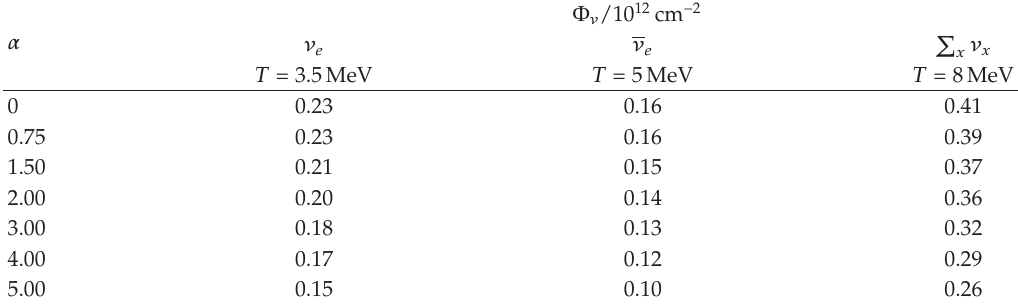
Table 3: The (cid:3) time integrated (cid:4) neutrino flux, in units of 10 12 cm − 2 , at a distance 10kpc from the